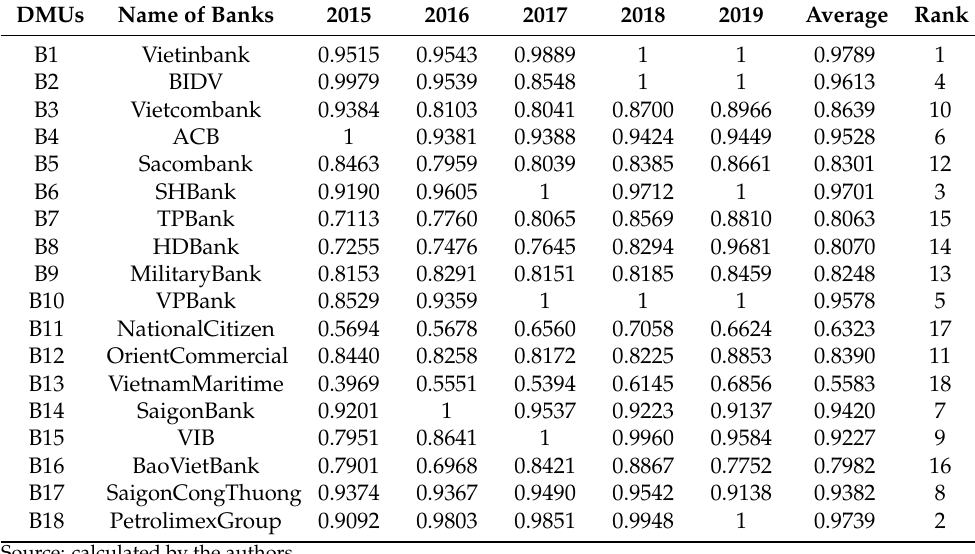
Table 8. The Window results of the whole period (2015–2019).